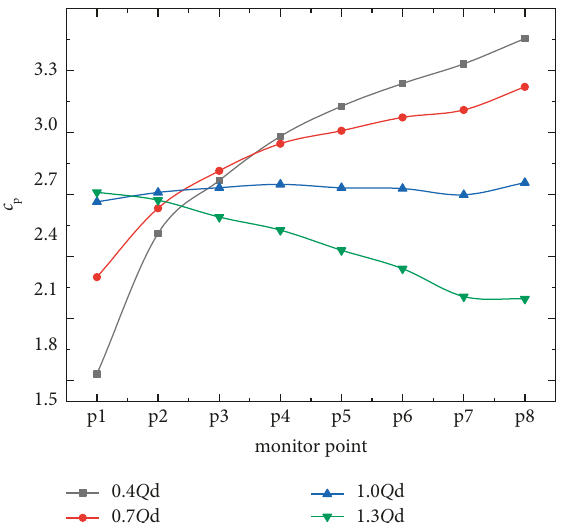
Figure 10: Average pressure distribution under different flow rates.